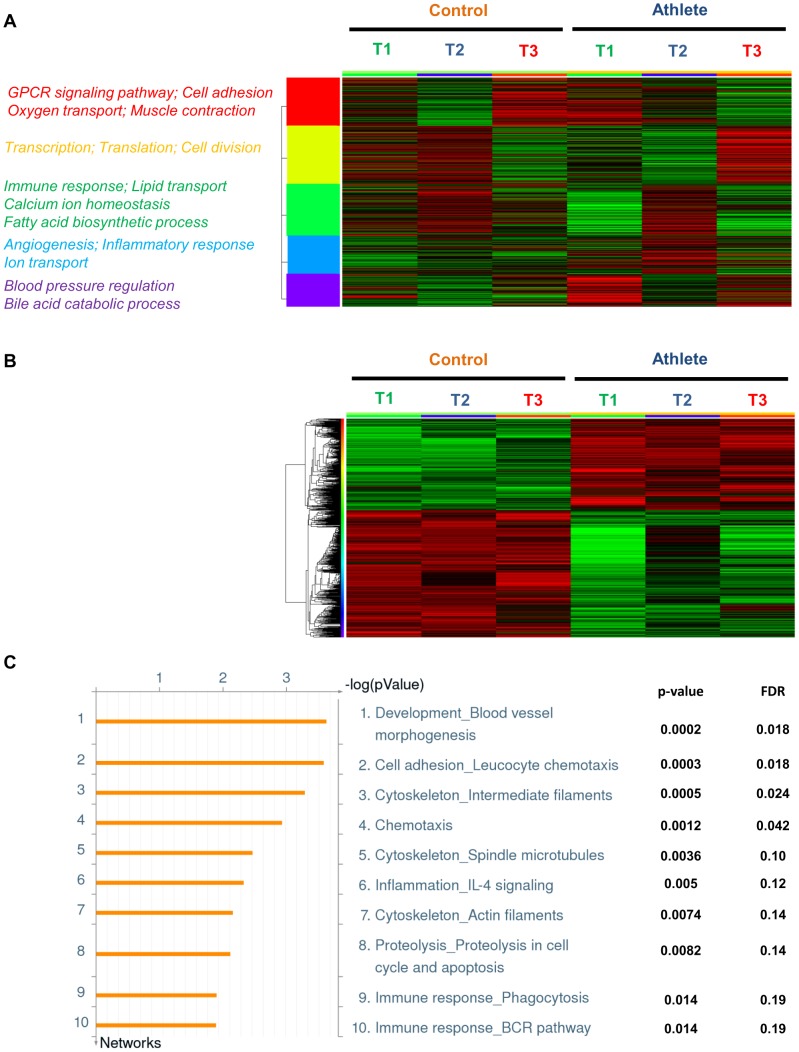
Gene expression in control and athlete subjects.(A) Heatmap of the entire genome including all normalized and filtered probes in athlete and control groups across all time-points (T1: 24 hrs before exercise; T2: immediately after exercise; T3: 24 hrs after exercise). Red represents an up-regulation, and green a downregulation in gene expression. The probes were clustered by k-means clustering into 5 broad clusters. Representative Gene Ontology (GO) biological processes of each cluster are shown in their respective colours on the left. (B) Representative heatmap of probes found significantly different between athlete and control groups across all time-points (T1: 24 hrs before exercise; T2: immediately after exercise; T3: 24 hrs after exercise). The probes were clustered by hierarchical clustering. Fold change>1.5; False Discovery Rate (FDR)<0.1. (C) Top 10 networks representing genes differentially expressed between athlete and control groups across all time points by Metacore analysis, with corresponding p-values and FDR.